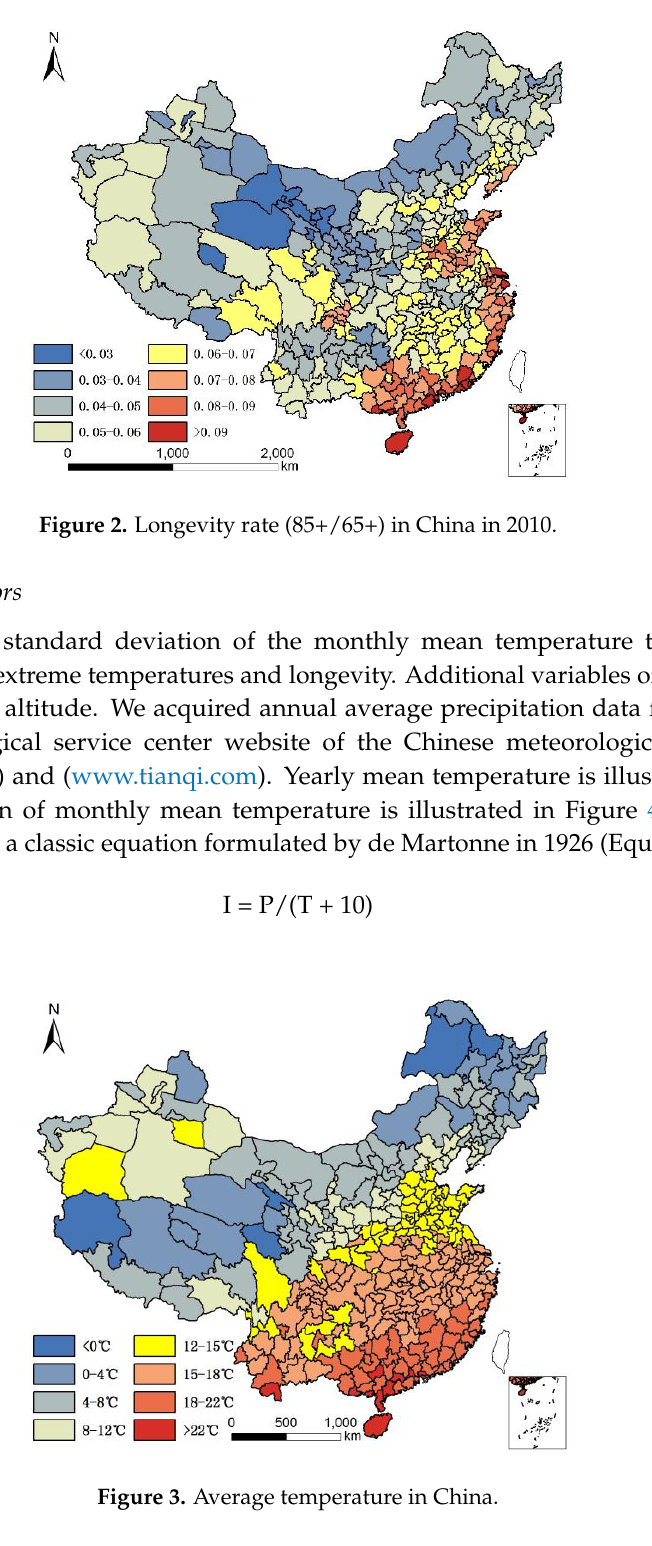
Figure 3. Average temperature in China.